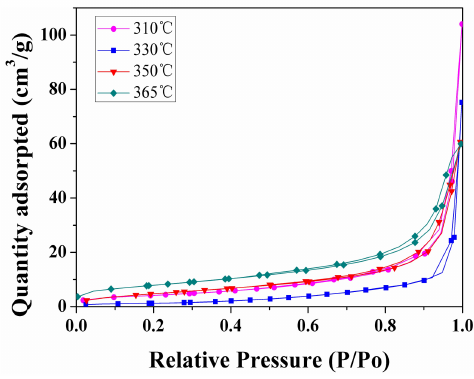
Figure 8. Nitrogen adsorption isotherms for spent samples extracted by sub-critical water for 150 h at different temperatures.